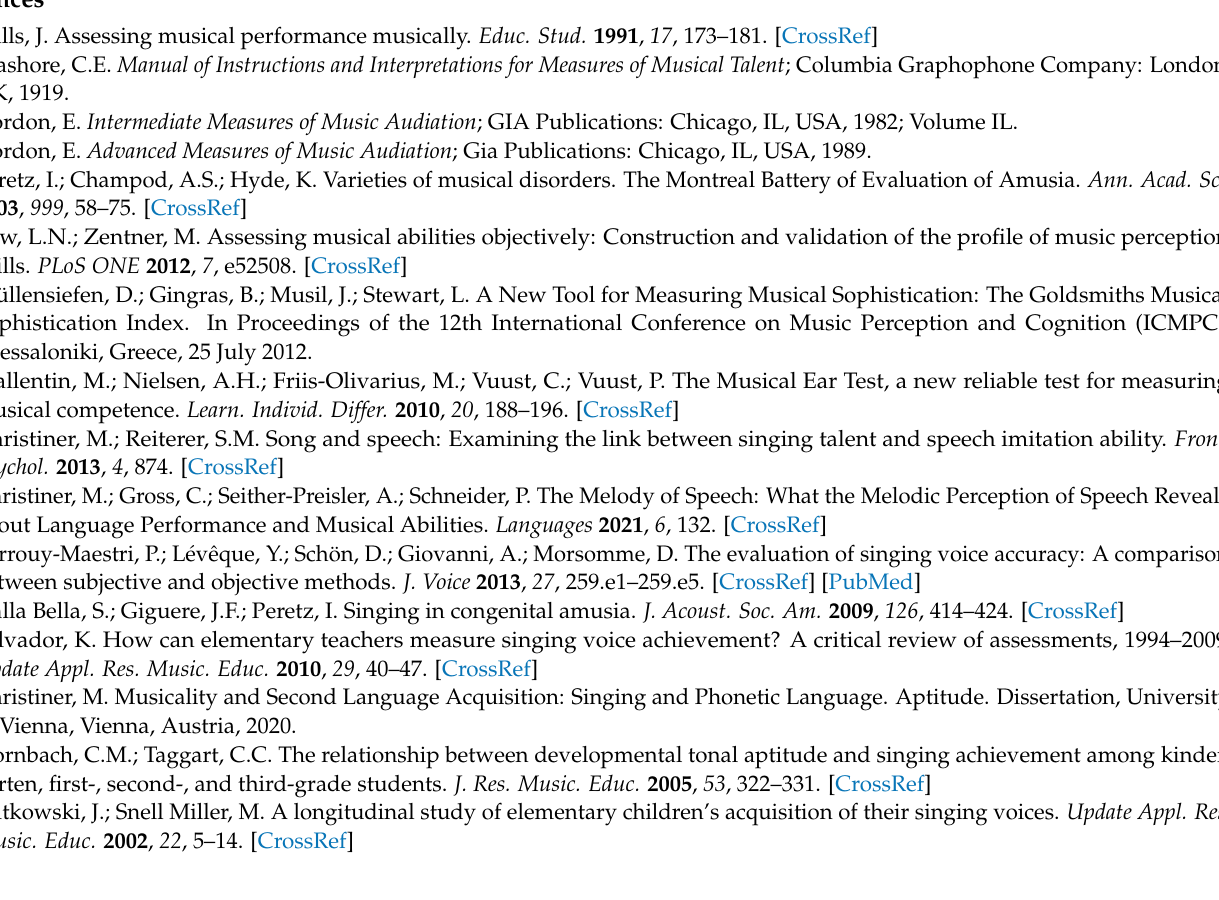
criteria of the MuPAS, Table S8: post hoc analyses of the six variables of the Musical Performance Assessment Scale, Table S9: correlations of the outcome variables and the discriminant functions, Table S10: post hoc analyses of the MEG variables, Table S11: correlations of the outcome variables and the discriminant